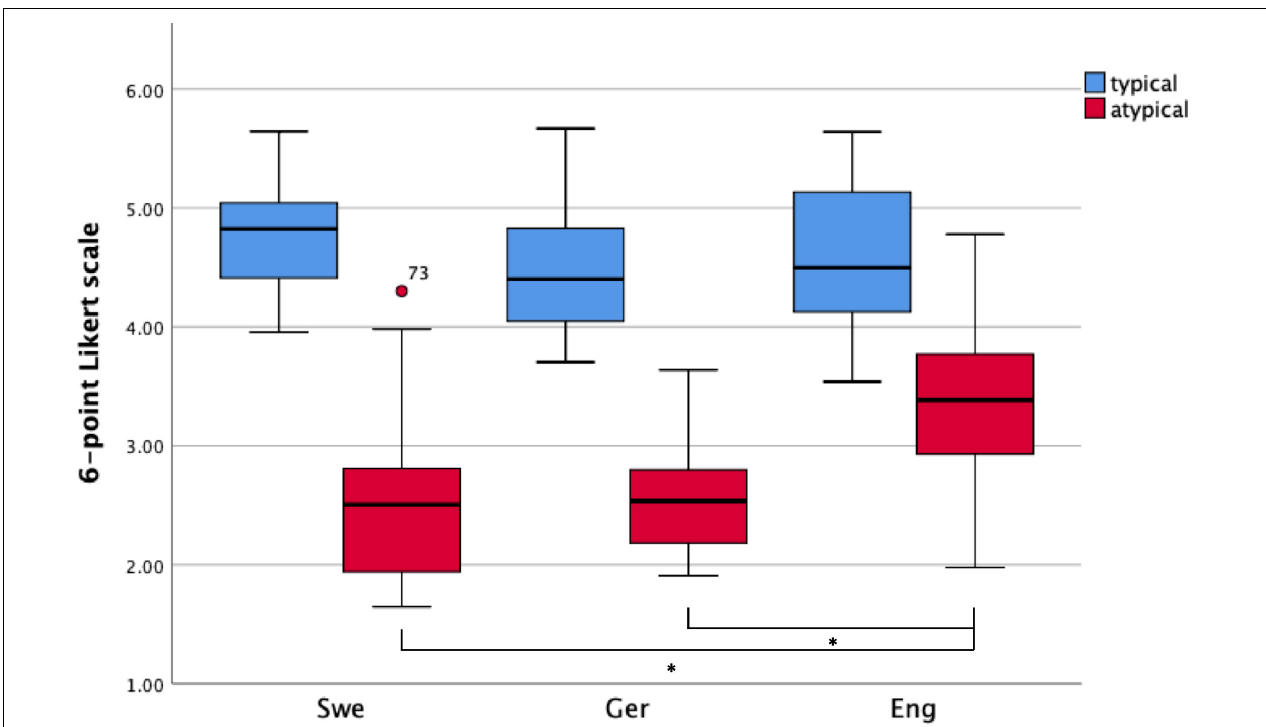
FIGURE 4 | Appropriateness ratings on a 6-point Likert scale (blue, typical verb use; red, atypical verb use) for each language group, i.e., Swedish (Swe), German (Ger), and English (Eng). The solid line within the box represents the average, while the whiskers represent quartiles 1 and 4. The ring above quartile 1 in the Swedish group indicates an outlier (more than two standard deviations higher than the average). These boxplots visualize that the English group does not make as large a difference between typical and atypical verb use as the other two groups. * p <